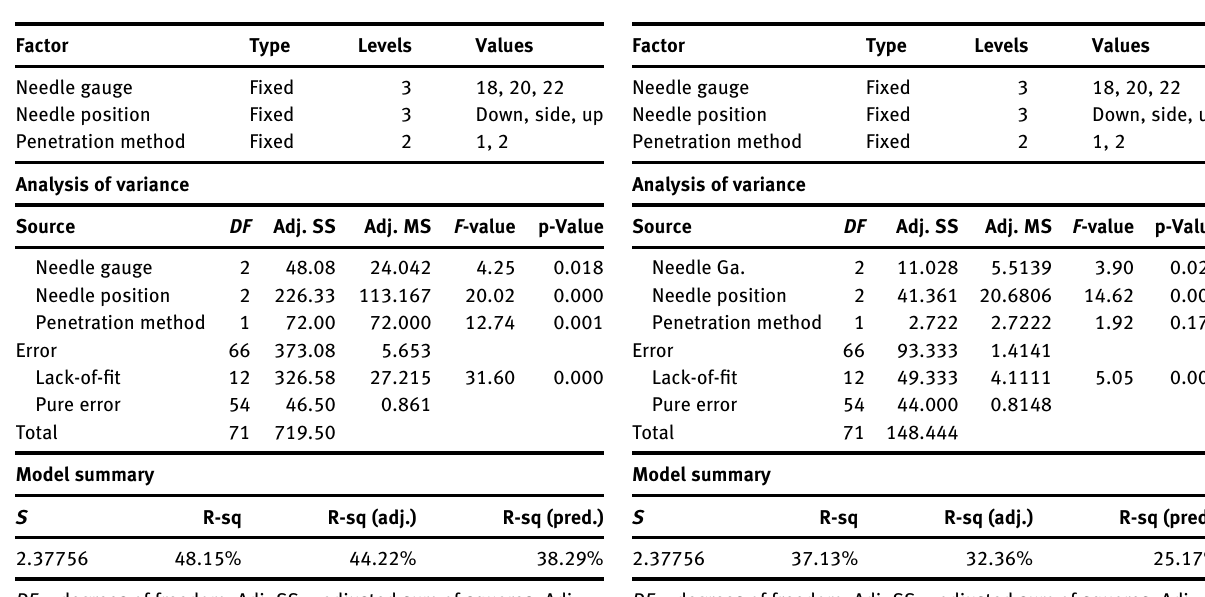
Table  : General linear model – fragmentation vs. needle gauge, needle position, and penetration